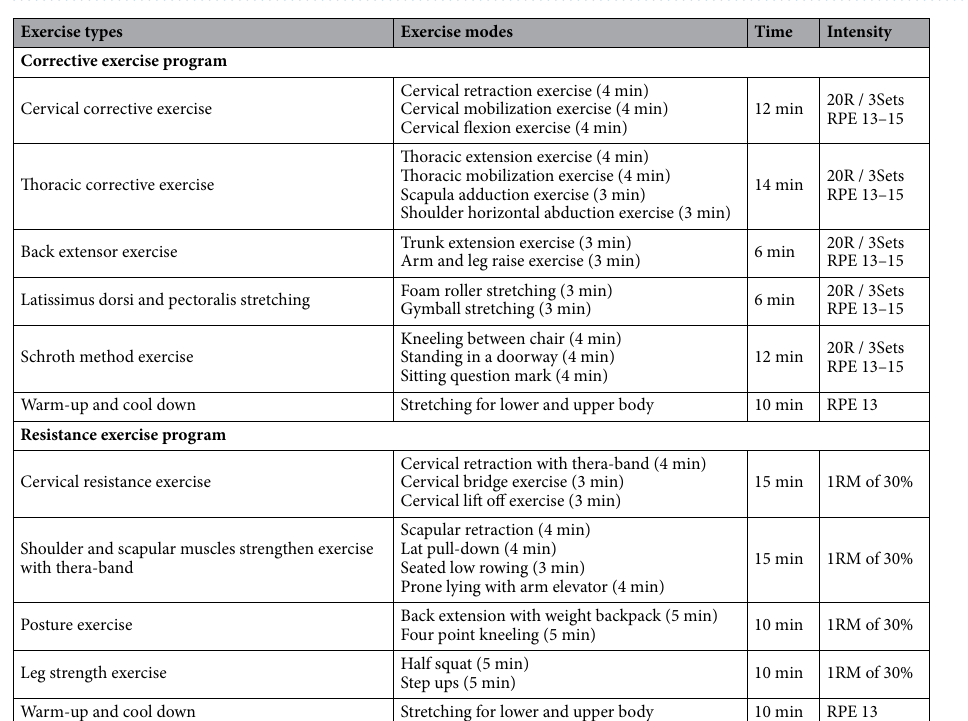
Figure 4. MRI (magnetic resonance imaging) imaging of the cross-sectional area of the perivertebral space. ( a ) Longus colli muscle; ( b ) Longus capitis muscle; ( c ) Multifidus muscle.